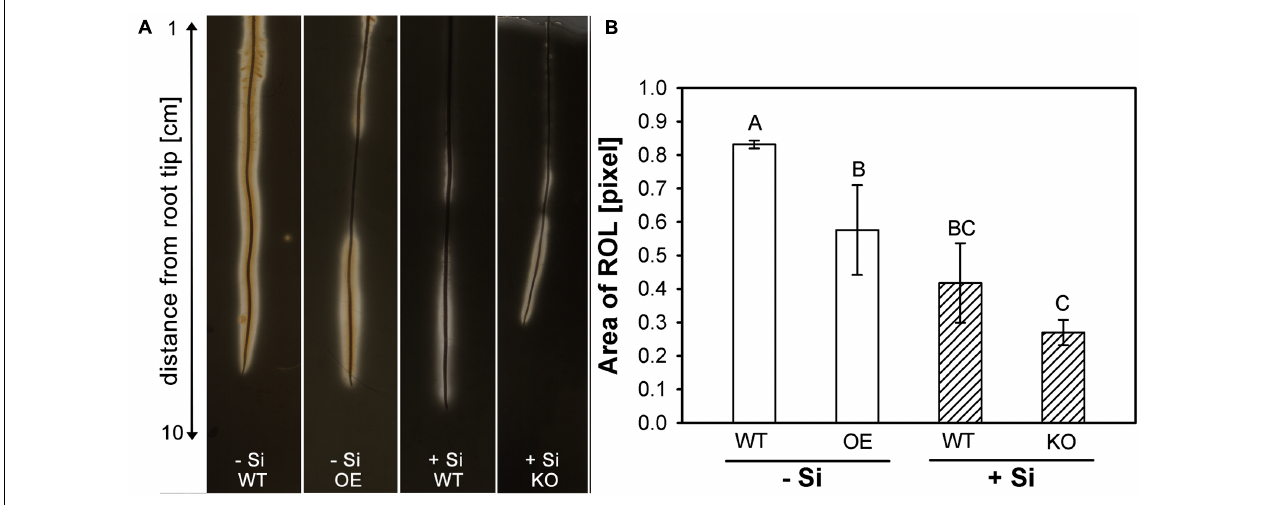
FIGURE 4 | (A) Visualization of radial oxygen loss (ROL) from rice roots using a FeS-agar. The WT plants were grown with low (–Si) and high (+Si) Si supply (conc. are given in the legend of Figure 1 ), whereas the insertion line 1B-14436 (KO) was cultivated only in + Si and mutant 3A-16329 (OE) only in –Si; (B) Area of ROL of roots of WT plants and the mutation lines 1B-14436 (KO) and 3A-16329 (OE). Different letters indicate a significant difference between treatments; Tukey test with p < 0.05.